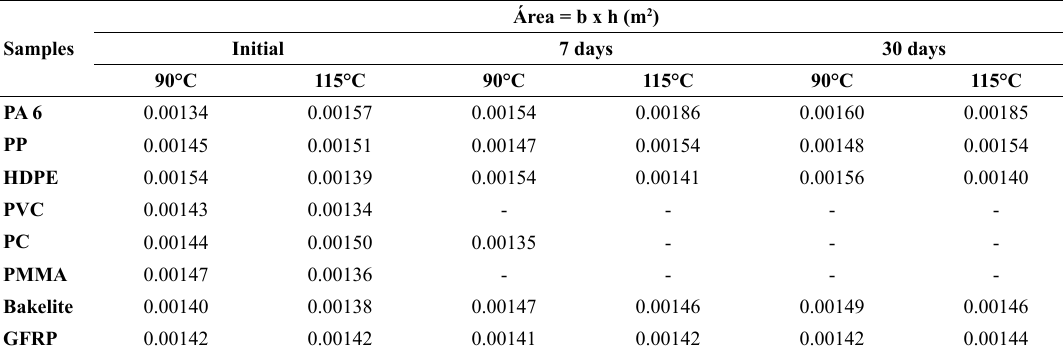
Tabela 3. Physical and chemical properties of HDPE and PP. Property